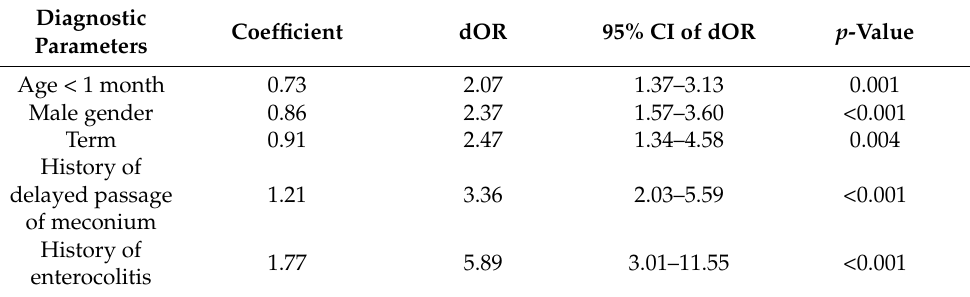
Table 2. Regression coefficient, diagnostics odds ratio (dOR), and 95% CI of selected diagnostic parameters derived from logistic regression after multiple